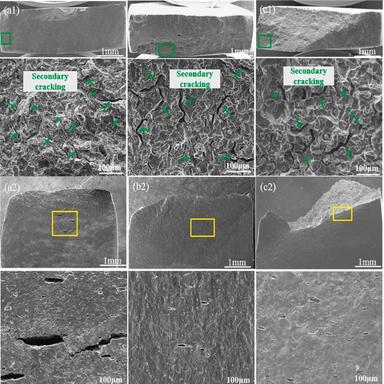
Cross sectional (1) and side (2) morphologies of fracture for steel samples in the simulated solution at − 1200 mV (a) TMCP steel, (b) DQ steel, and (c) QT steel.